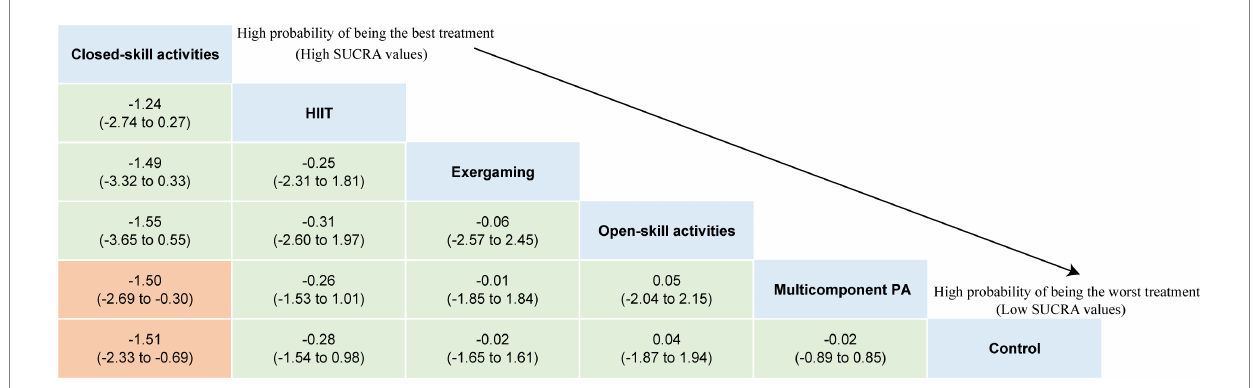
FIGURE 7 League table of outcome analyses for inattention. PA, physical activity; SUCRA, the surface under the cumulative ranking